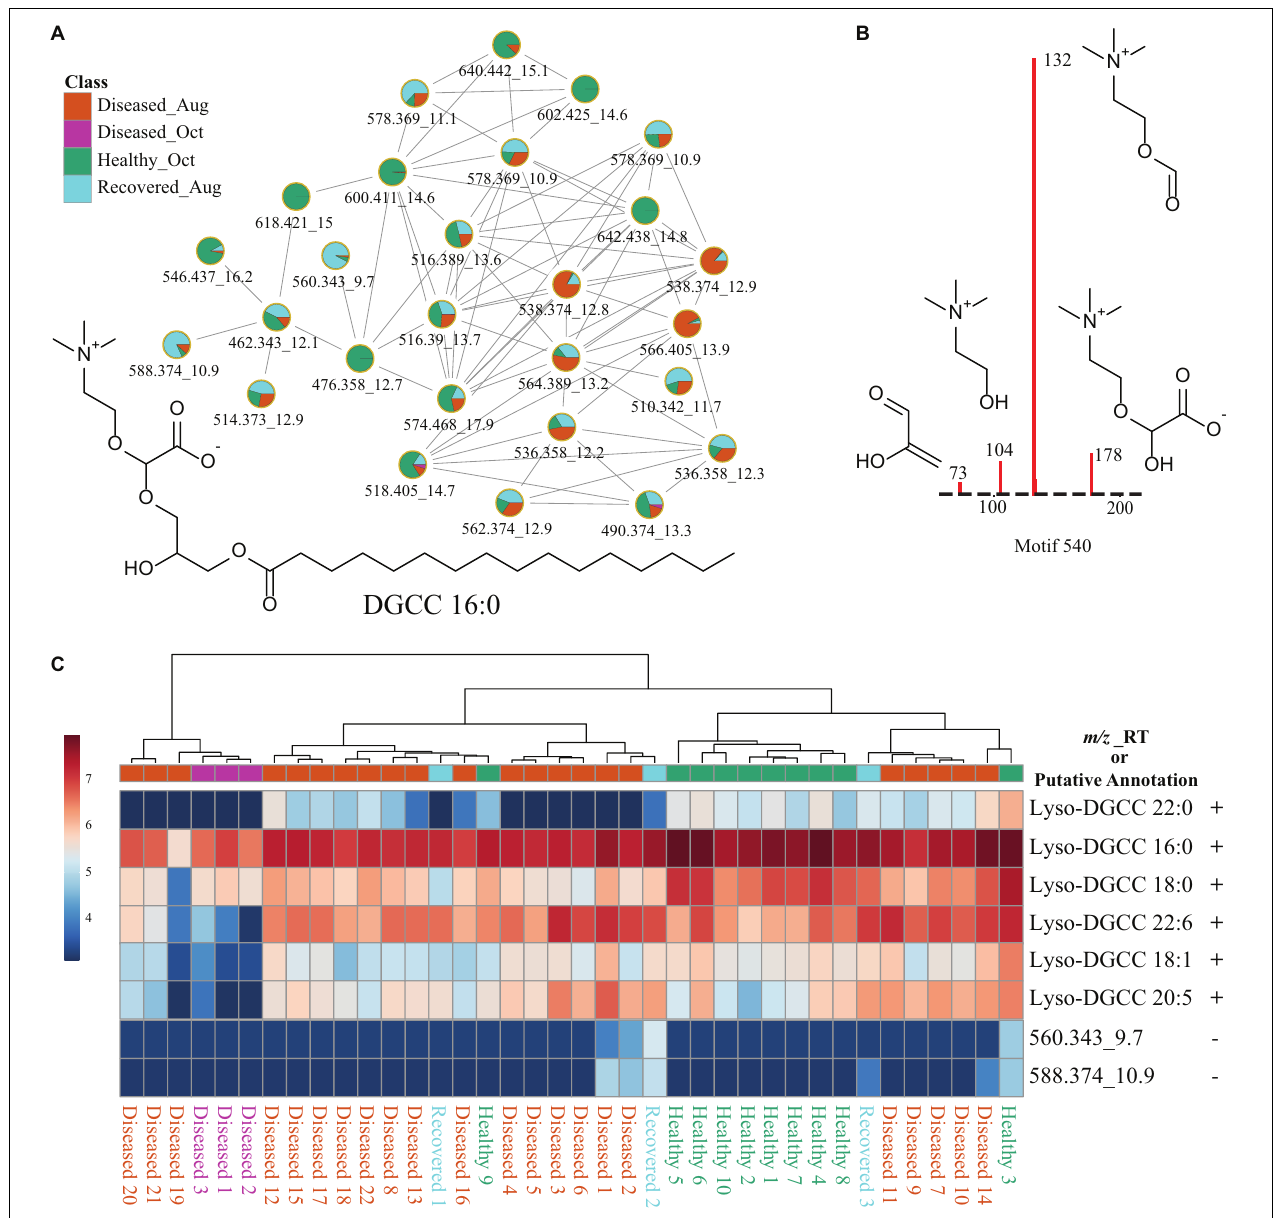
FIGURE 8 | Description of betaine lipids using molecular networking, substructure discovery via MS2LDA, and distribution in corals via heat maps. (A) Shows the FBMN of betaine lipids. (B) Shows specific fragments observed in the MS 2 spectra of betaine lipids that constitute the MS2LDA sub-structure motif specific to the head group of betaine lipids. This motif enabled annotation of additional betaine lipids not observed in the network of nodes in (A) . (C) Heat map of six betaine lipids across healthy, diseased, and recovered coral samples grouped via analysis of variance from LC-MS generated in MetaboAnalyst. The scale bar represents log-transformed intensity of these lipids. This figure illustrates a subset of betaine lipids. A comprehensive list of all betaine lipids annotated in this study and the heat map for these features is provided in Supplementary Table 2 and Supplementary Figure 5 . The m/z _RT value or putative annotation are included for each feature. The ± indicates presence or absence of this feature in the LC-MS data acquired on cultured